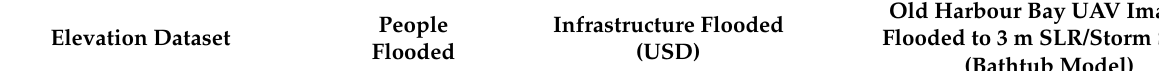
Table 3. Calculated damages to people and infrastructure under 3 m-digital surface model (SLR) using various DEM datasets.